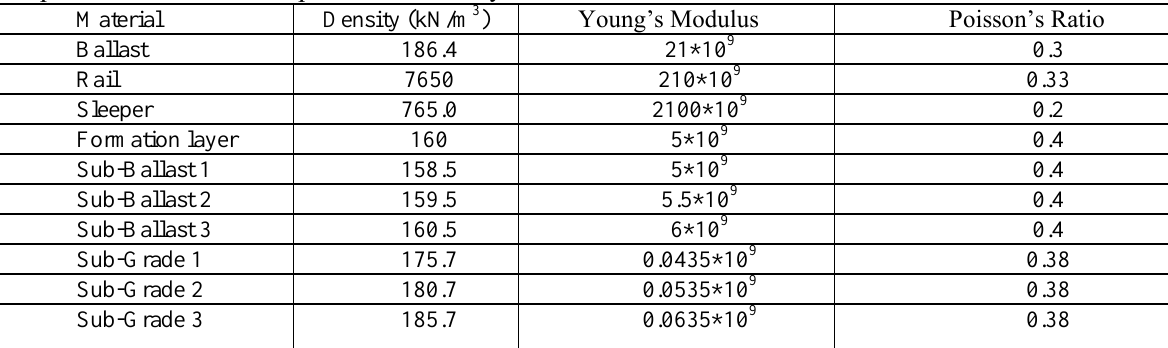
Properties of different components of railway